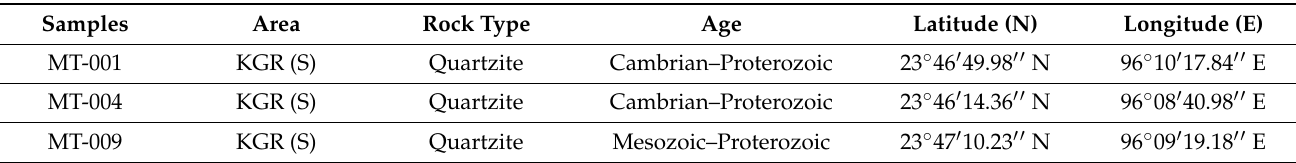
Table 1. Sample lithology, locations, and depositional ages from this study. Abbreviations: K-G Range (S) = southernmost part of Katha-Gangaw range; K-G Range (L-M) = Lower middle part of Katha-Gangaw range; K-G Range (U-M) = Upper middle part of Katha-Gangaw range; K-G Range (N) = Northernmost part of Katha-Gangaw range; Kumon range (S) = southernmost part of Kumon Range; Gnt-Staurolite Schist = Garnet–Staurolite